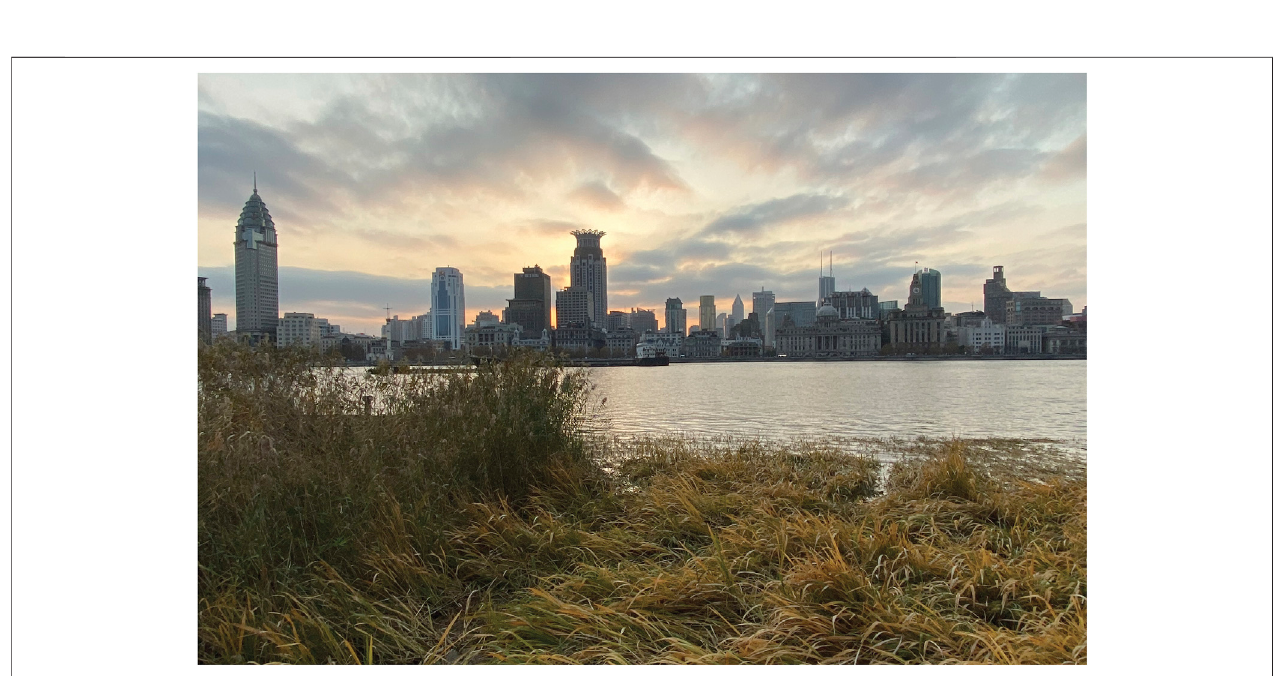
FIGURE 6 | Ecological ‘ stepping-stone along the Huangpu River at Lujiazui, the city center (Photo by author, March 2020.